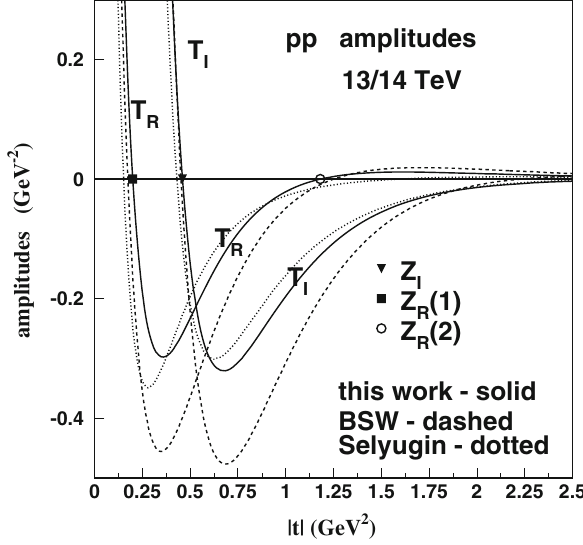
Fig. 14 Scattering amplitudes T R ( t ) and T I ( t ) in comparison with other models: KFK solution of Eqs. (11, 14) and Table 1 in solid line, BSW model [49] in dashed line and Selyugin’s HEGS model [50–52] in dotted line. The solutions are similar, with zeros similar positions, and with dominance of the real part (with positive sign) for large | t